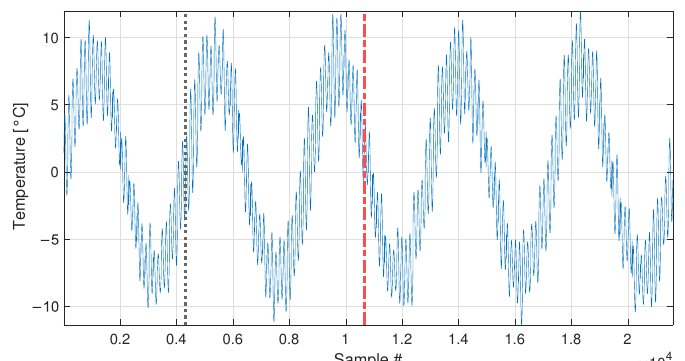
Figure 13. Simulated temperature trend: long-term and short-term temperature trends. The vertical dotted line identifies the number of samples used as baseline in sim 4. The beginning of the damage- related data is indicated by a red vertical dot-dashed line.